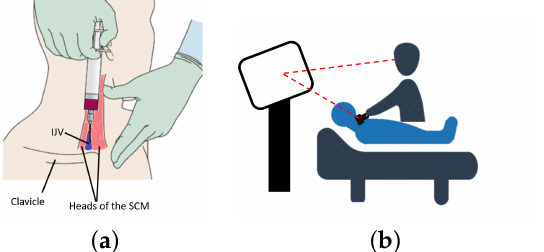
Figure 1. Comparison of guidance technique for CVC: ( a ) anatomical landmarks, ( b ) US-only